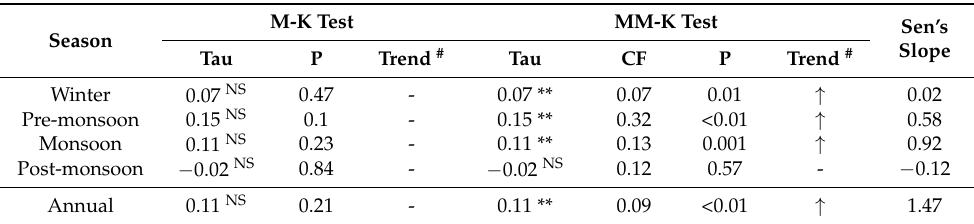
Table 4. M-K and MM-K test statistic (Tau) and Sen’s slope estimate for the SIK subdivision for seasonal and annual rainfall (mm) data.